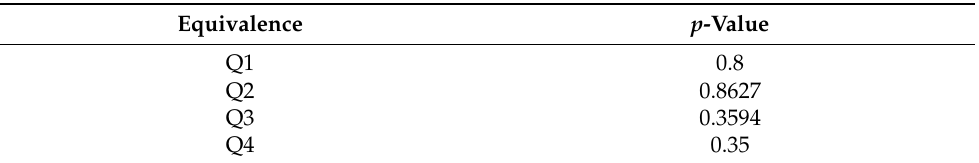
Table 2. Homogeneity of the control and experimental groups based on the students’ profile and the team creation.